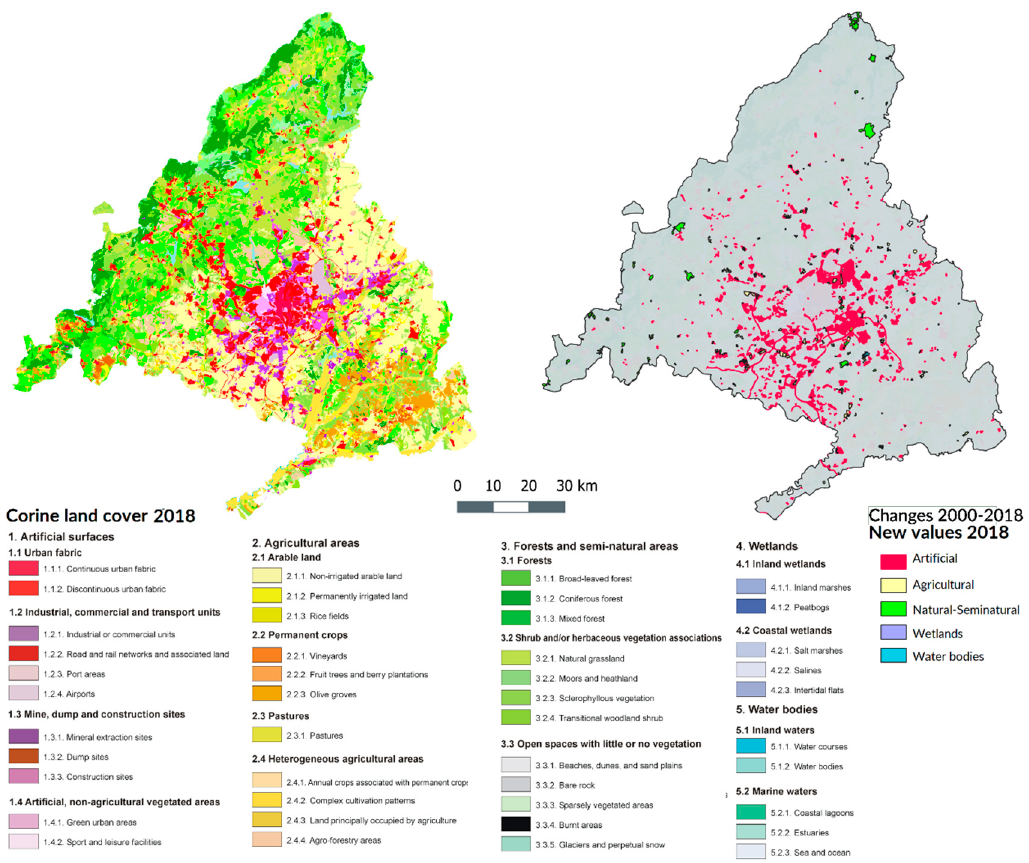
Figure 2. Land Use Changes Comunidad de Madrid 2000–2018. Source: The author based on CORINE Land Cover (CLC) databases.